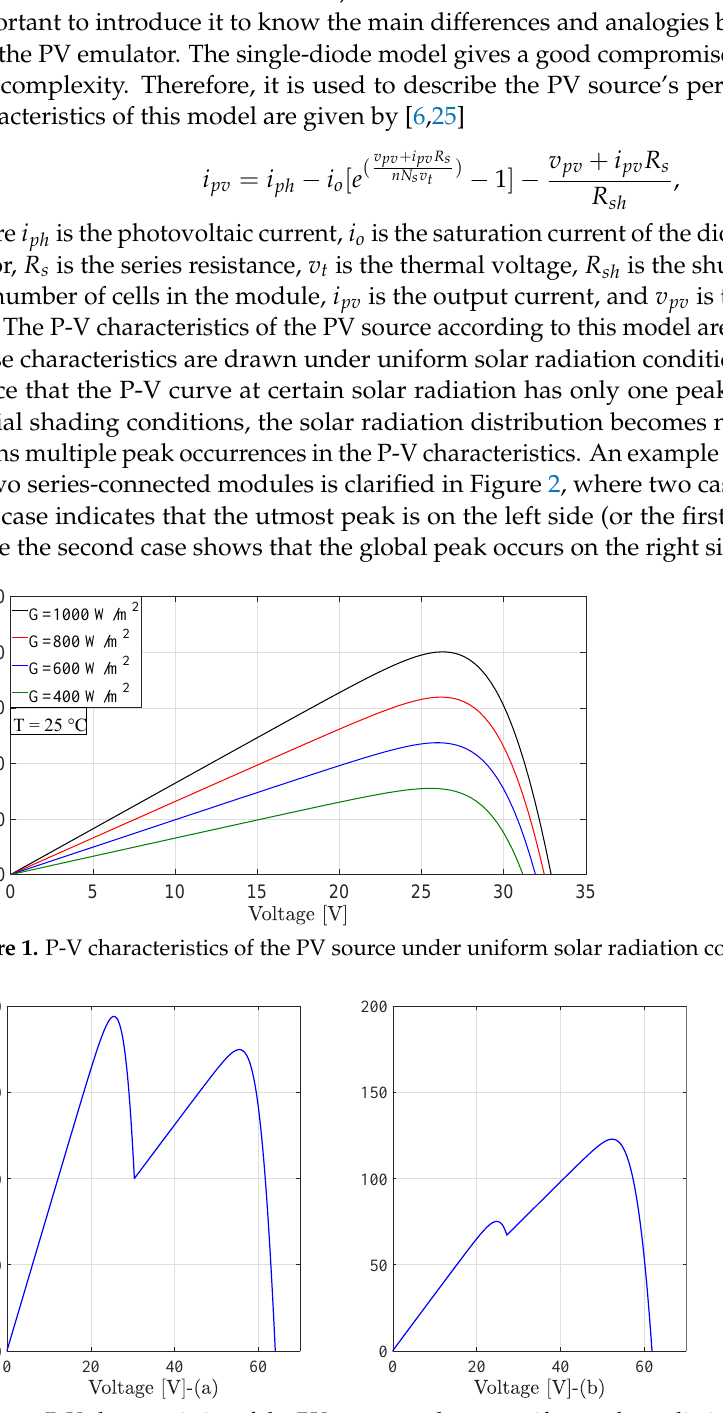
Figure 2. P-V characteristics of the PV source under nonuniform solar radiation conditions: ( a ) The global peak on the left side ( b ) The global peak on the right